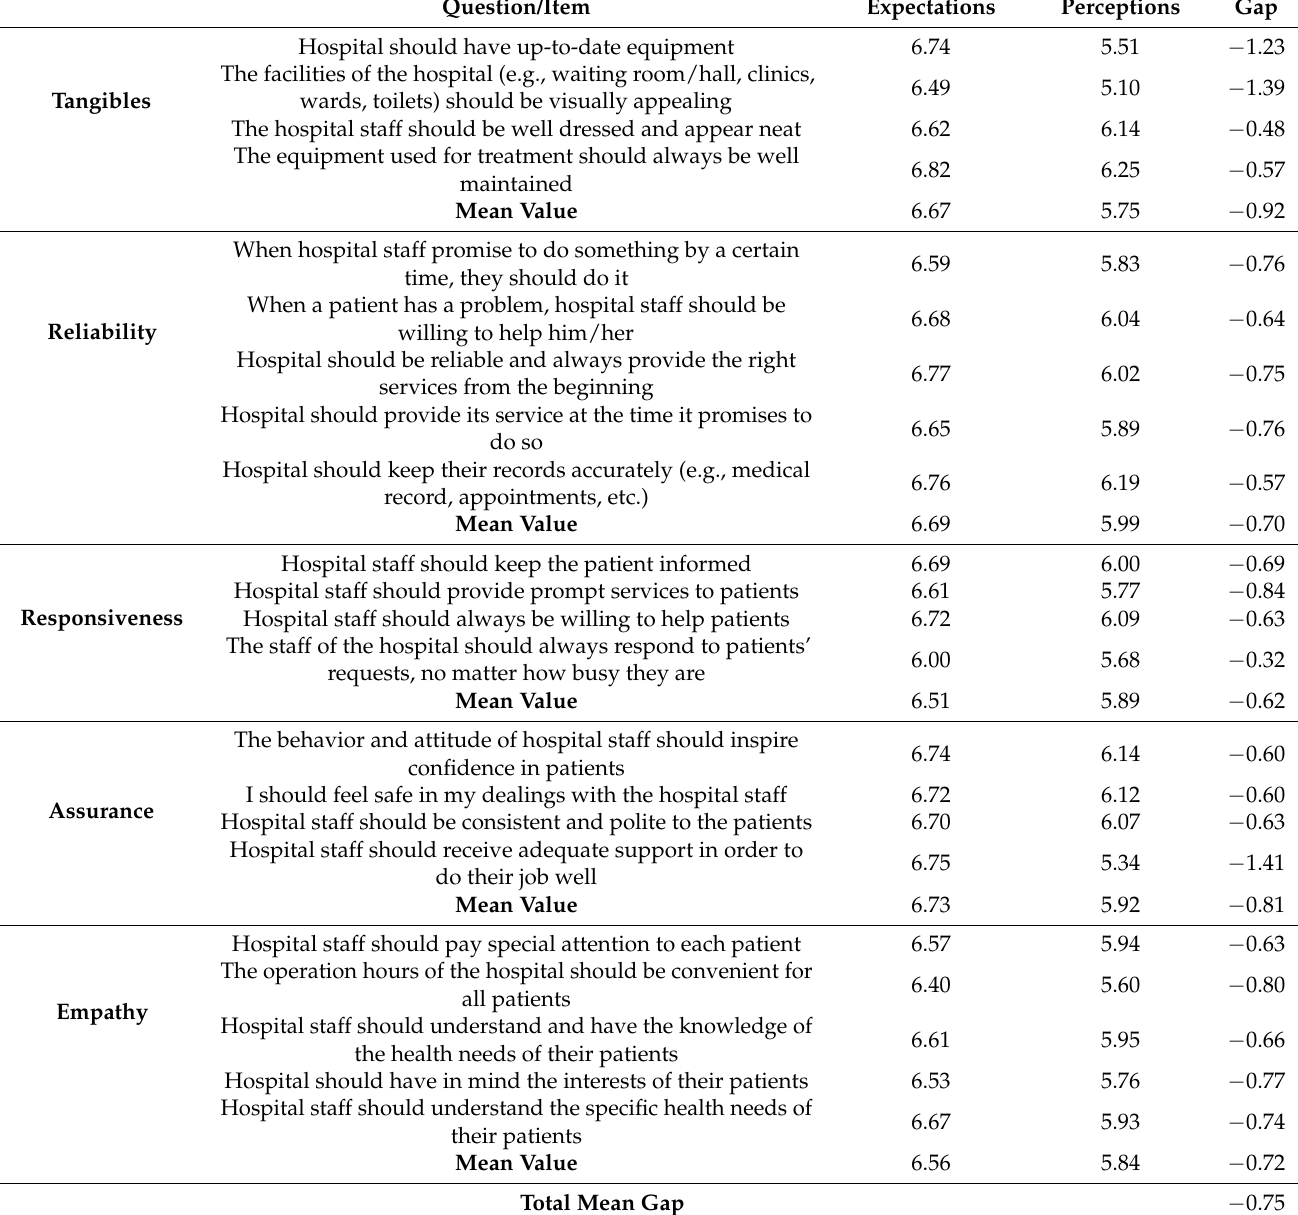
Table 3. Results for Expectations, demographic characteristics of the respondents by quality